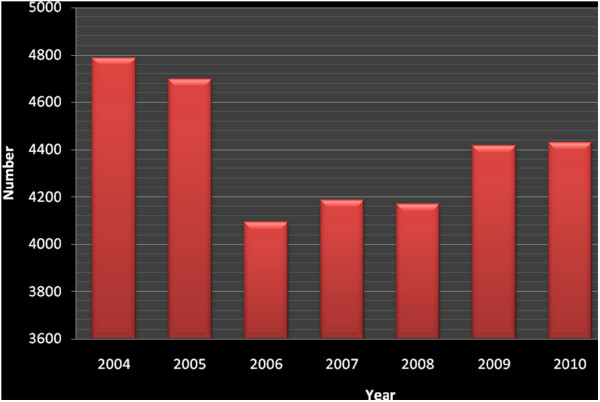
Cases of Visceral Leishmaniasis,Ethiopia,2004-2010[26].